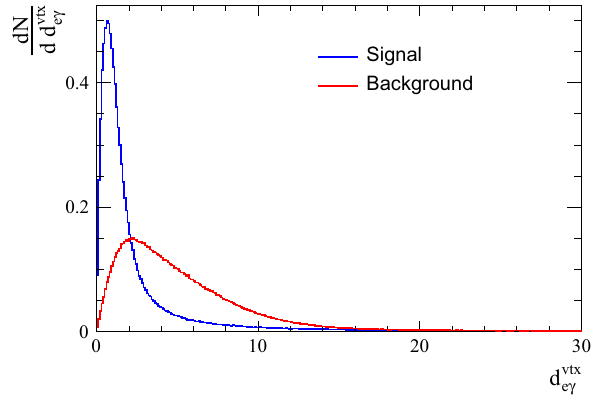
Fig. 5 Distribution of the normalized distance between the positron andphotonvertices,forsignal(blue)andaccidentalbackground(black) events, with a 0 . 1 X 0 Lead